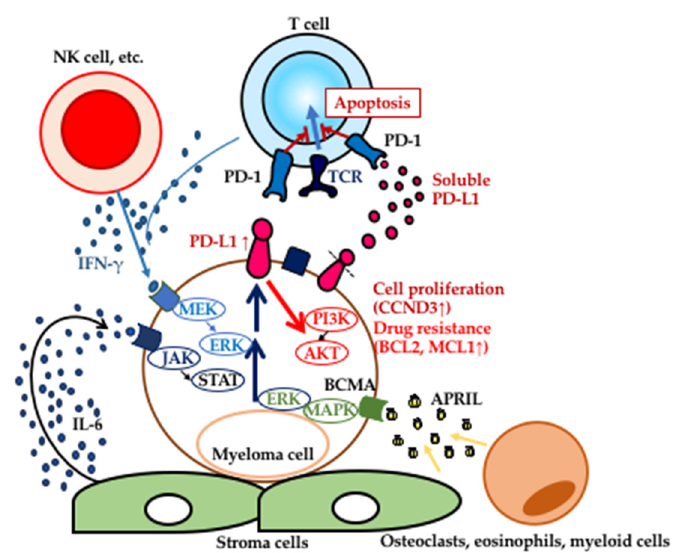
Figure 1. PD-L1 induced by the MM microenvironment.